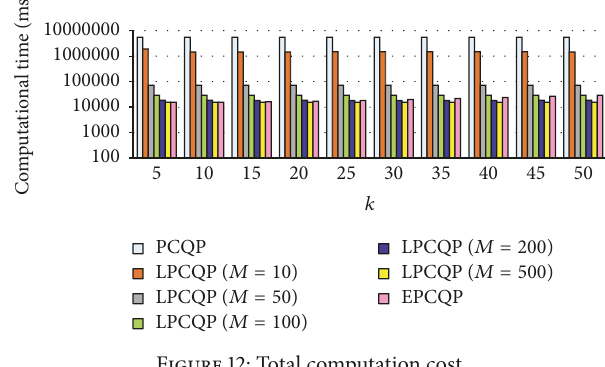
Figure 12: Total computation cost.